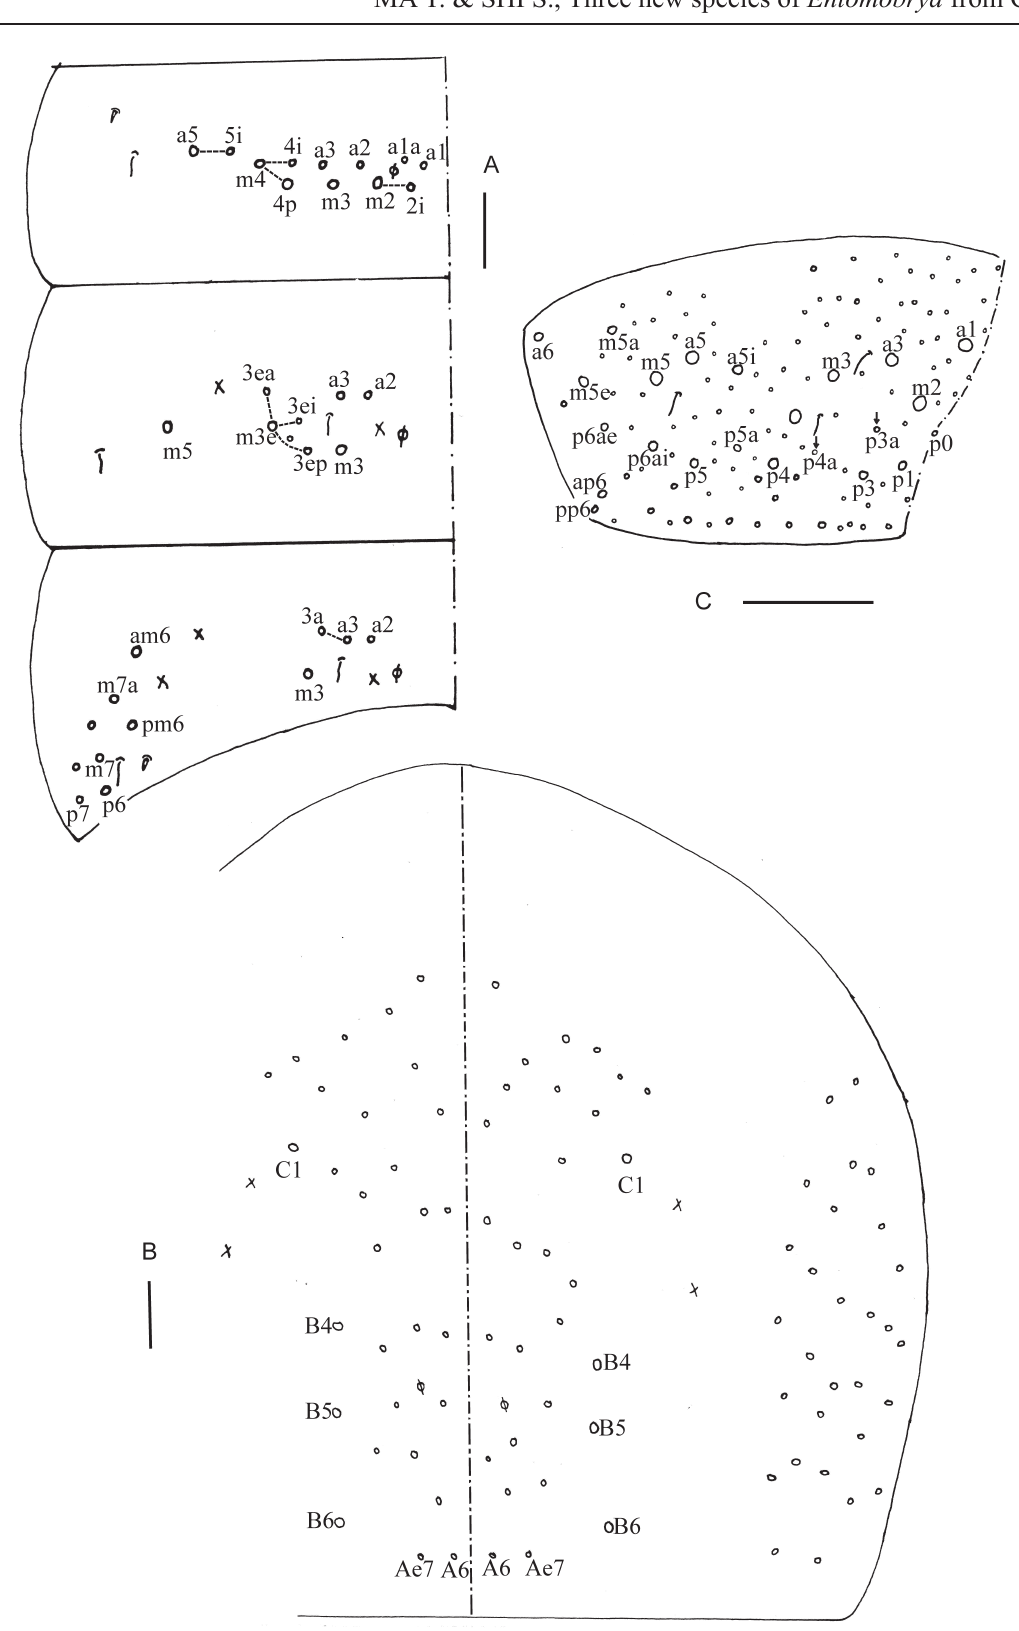
Fig. 9. Entomobrya polychaeta sp. nov. A . Chaetotaxy of Abd. I−III. B . Chaetotaxy of Abd. IV. C . Chaetotaxy of Abd. V. Scale bars: A–C = 50